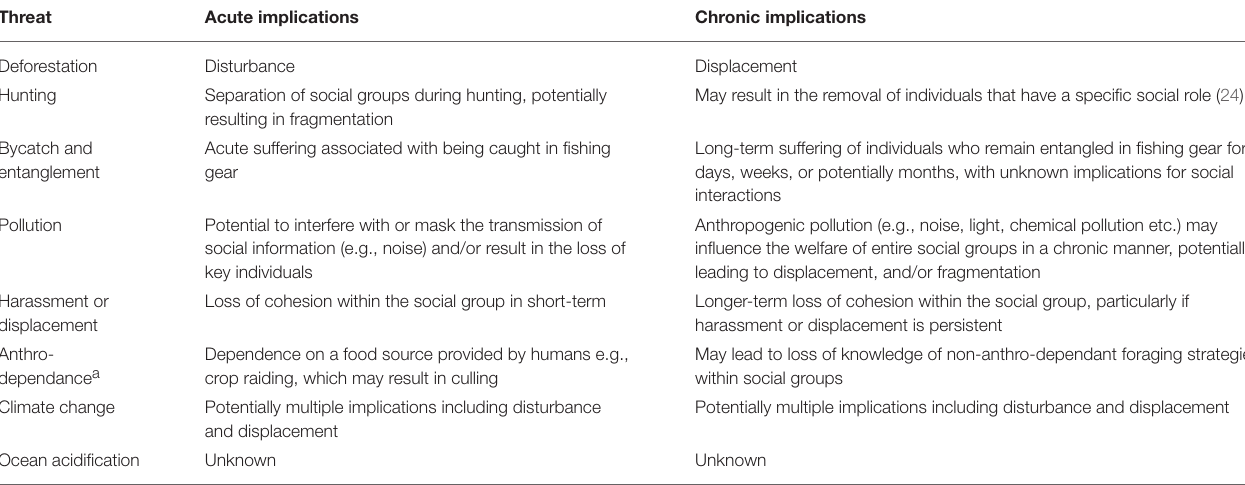
TABLE 3 | Acute and chronic implications of HIREC for sociality and